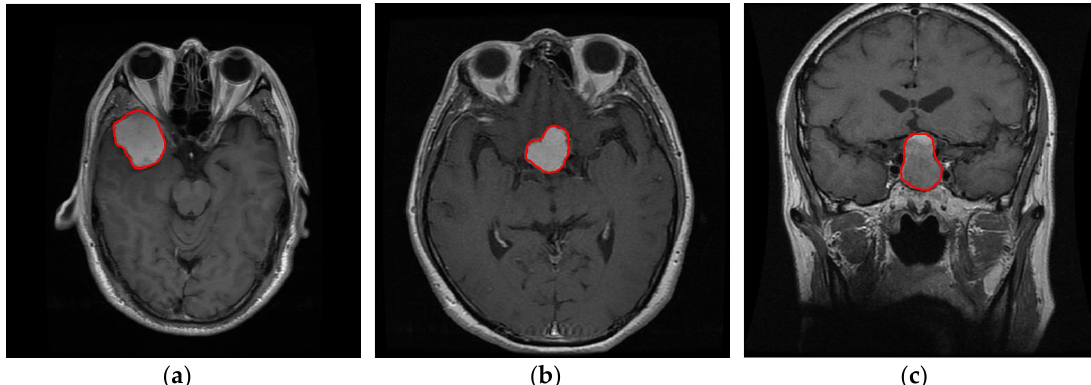
Figure 2. Head MRI examples. The red color illustrates the tumor area ( a ) glioma, ( b ) meningioma, ( c ) pituitary.